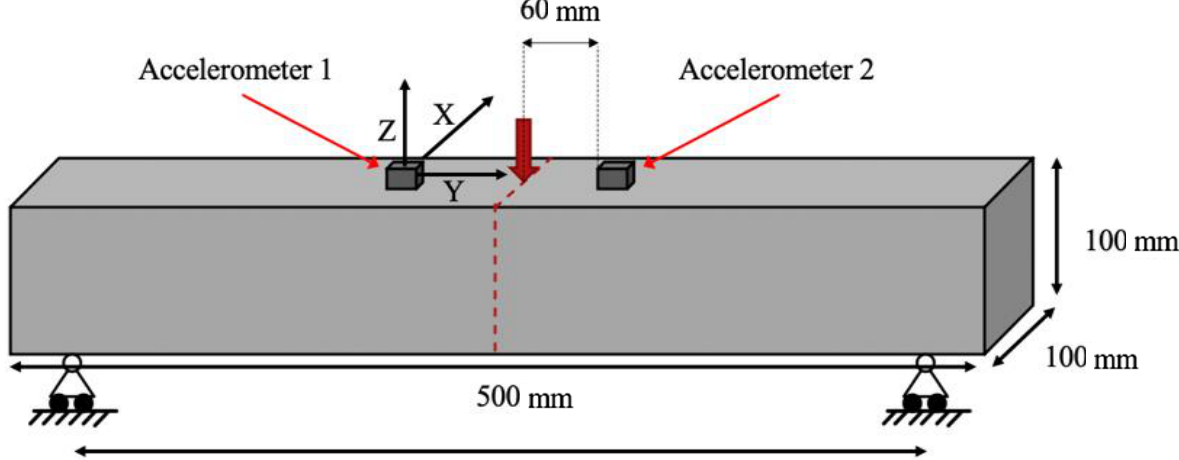
Figure 1. Experimental setup.